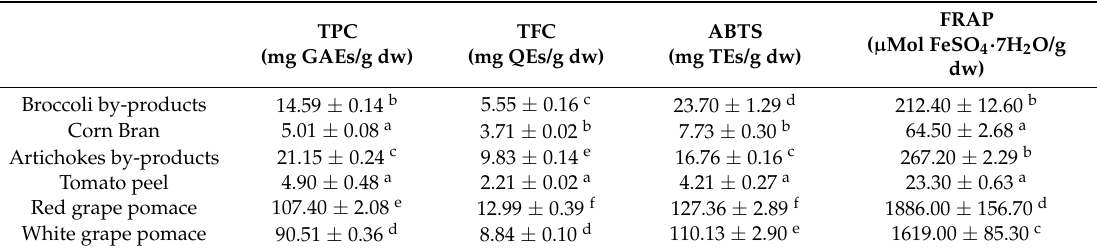
Table 1. Total phenolic content (TPC), total flavonoids content (TFC), and antioxidant activity measured by ABTS (2,2-azino-bis(3-ethylbenzothiazoline-6-sulfonic acid) diammonium salt) and FRAP (ferric reducing antioxidant power) assays of different